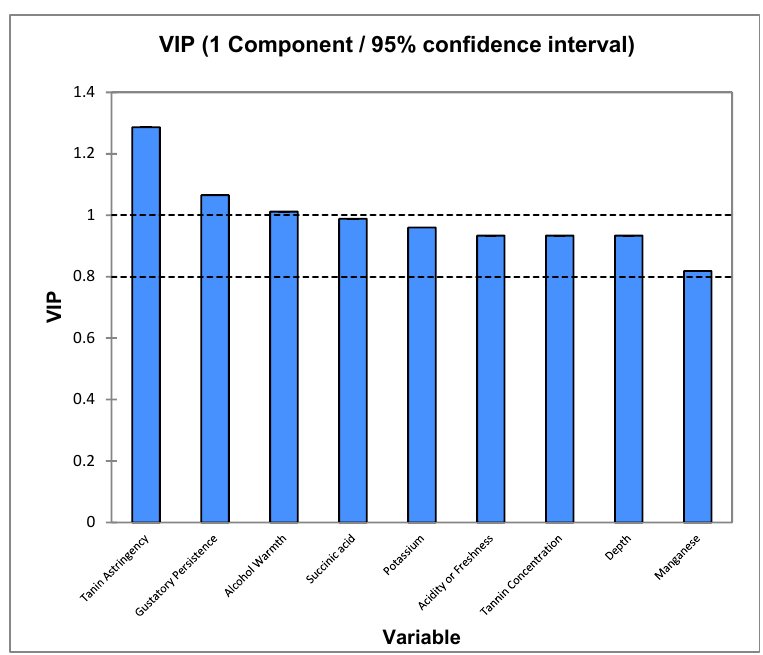
Figure 8. Variable Importance in Projection (VIP) graph of the model proposed for the gustatory “minerality” descriptor in red wines, based on the chemical and sensory profile of the six red wine samples.